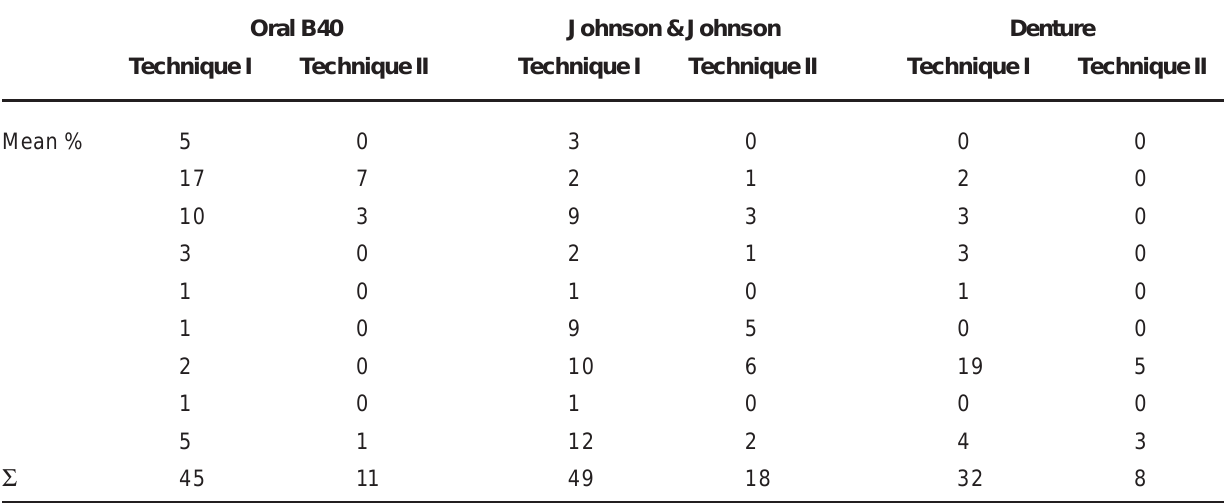
TABLE 1- Means of disclosed biofilm percentages on the internal surface of the evaluated complete dentures and sum of means